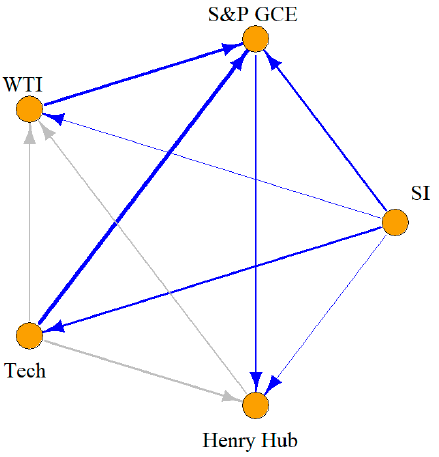
Figure 3. Net pairwise directional volatility connectedness.